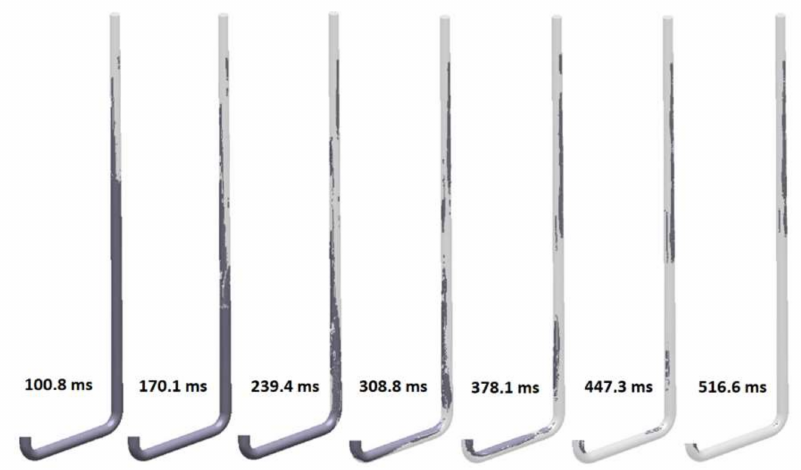
Figure 21. Air evacuation in round, reverse tapered sprue (S s 3),